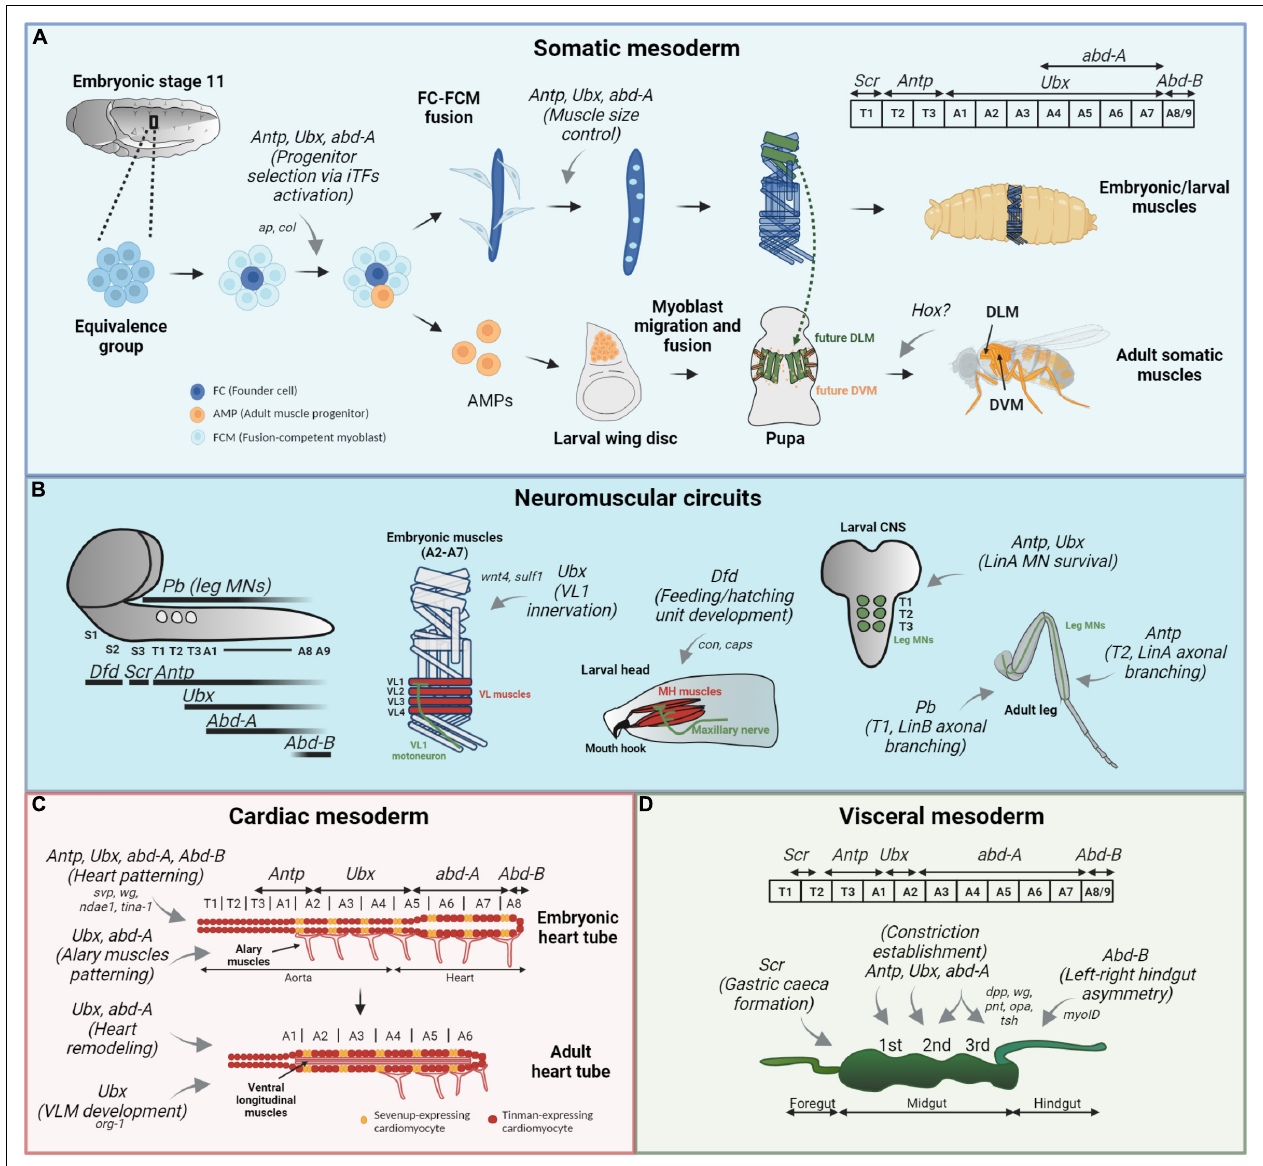
FIGURE 1 | Hox functions in Drosophila muscle patterning. Hox functions in the somatic (A) mesodermal patterning, neuromuscular circuit establishment (B) and cardiac (C) and visceral (D) mesodermal patterning are depicted by gray arrows, and their target genes are specified, if available. Their expression patterns are showed for each mesodermal derivative. (A) In the somatic muscle development, Antp, Ubx, and AbdA regulate progenitor selection from different equivalence groups (by binding to a muscle specific cis -regulatory region of ap and col , in LT and DA3 muscles, respectively) and later control muscle size by specifying the number of FCM (light blue cells) that will fuse with the FC (dark blue cell). The role for Hox in adult musculature, derived from AMPs (orange cells) is not clearly established. (B) Hox expression pattern in the larval CNS is depicted on the left, with Pb expression in leg MNs (circles). In this context, Ubx establishes proper connection between embryonic VL1 muscle and VL1-MN, by regulating wnt4 and sulf1 expression in the VL2 muscle. Dfd is responsible for the feeding and hatching motor unit development and maintenance in the larva, a process involving target genes con and caps . Antp and Ubx play a role in LinA lineage MN survival during larval development, and Antp further regulates correct morphology of this neurons in the adult T2 leg. Finally, Pb controls branching of some LinB MNs in T1 adult leg. (C) The heart tube is composed of Svp -expressing (orange cells) and Tin -expressing (red cells) cardioblasts and surrounding pericardial cells (not represented). Antp, Ubx, and AbdA are all involved in the patterning of embryonic heart tube, by controlling the expression of svp in the segment-specific manner. Furthermore, AbdA with Svp regulate wg expression in cardioblasts expressing Svp. AbdB on the other hand is a suppressor of cardiogenesis. Ubx and AbdA pattern alary muscles present in the abdominal segments. For proper heart remodeling, Ubx repression and AbdA function modulation are required. Finally, Ubx is involved in adult ventral longitudinal muscle (VLM) development. (D) In the embryonic visceral mesoderm, Antp establishes the first, Ubx and AbdA the second and AbdA the third midgut constriction. A complex genetic network involving dpp , wg , pnt , opa , and tsh is involved in the middle constriction development. Scr is involved in the formation of gastric caeca in the anterior midgut (caeca are not represented) and AbdB is responsible for the correct left-right embryonic hindgut asymmetric morphology via myoID